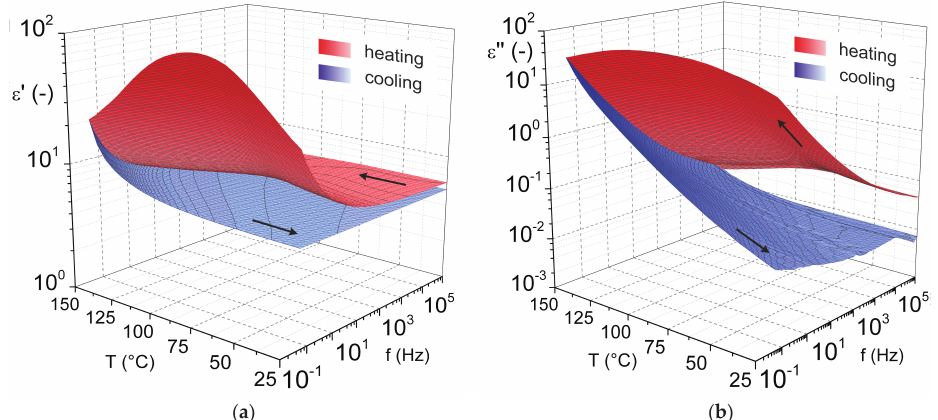
Figure 2. 3D interpretation of frequency-temperature dependencies of ( a ) dielectric constant and ( b ) loss factor for heating (red scale) and cooling (blue scale) of MgO